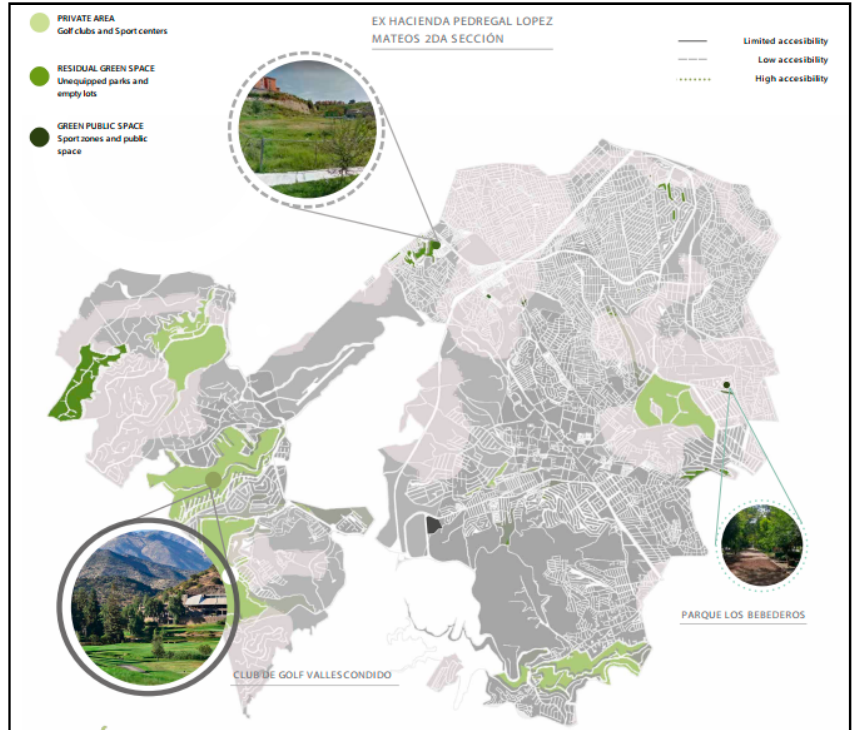
Figure 3. Green areas in Atizapán de Zaragoza. (figure by authors, with data from PMDU 2015 [44], Google maps, and field survey).